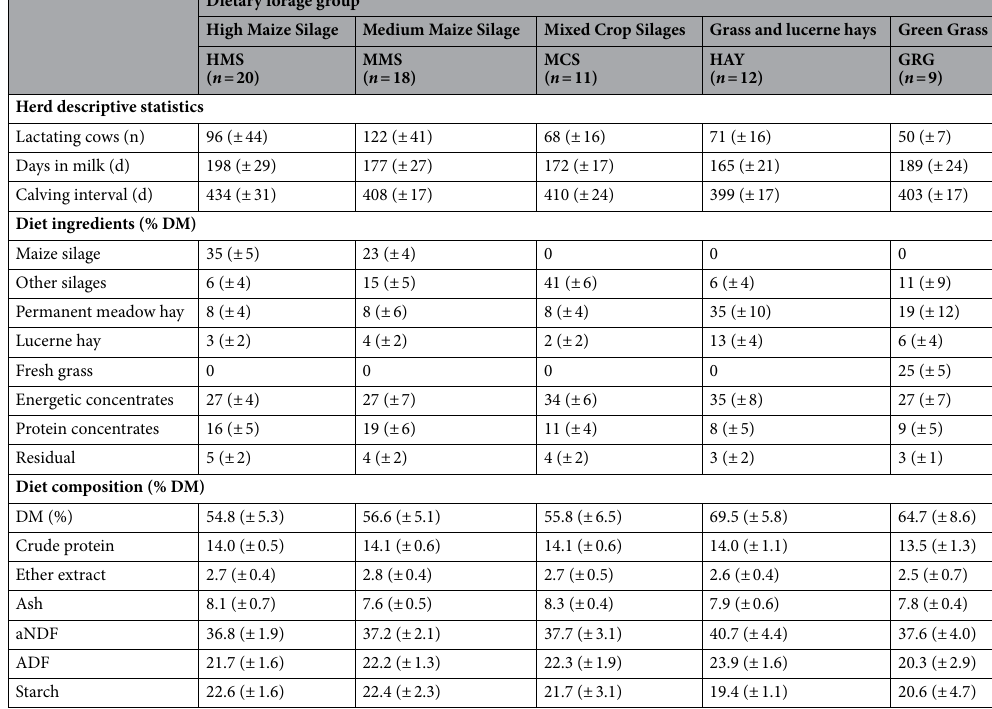
Table 1. Herd descriptive statistics (average ± SD); diet formulation (%) and proximate composition (% on DM) of the five feeding groups according to the main roughage source. Other silages , sorghum, wheat, lucerne, grass, ryegrass; energetic concentrates , maize products, sorghum mash, barley meal; protein concentrates , soybean products, sunflower meal; residual , straw, bran, beet pulps, salts, mineral-vitamin premix; aNDF , neutral detergent fibre; ADF , acid detergent